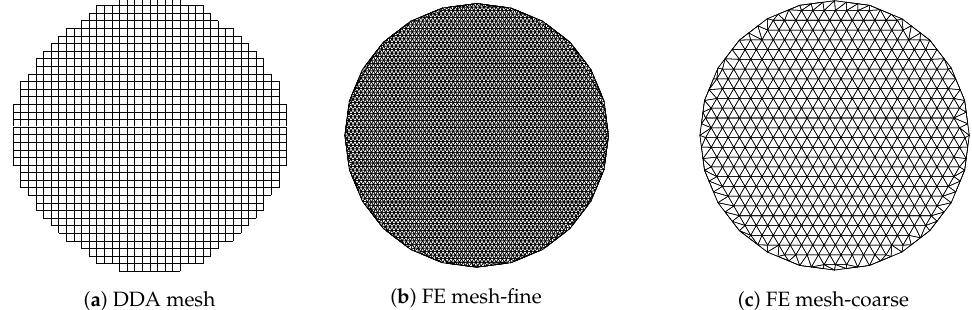
Figure 5. Schematic representation of imaging domain together with the antenna array